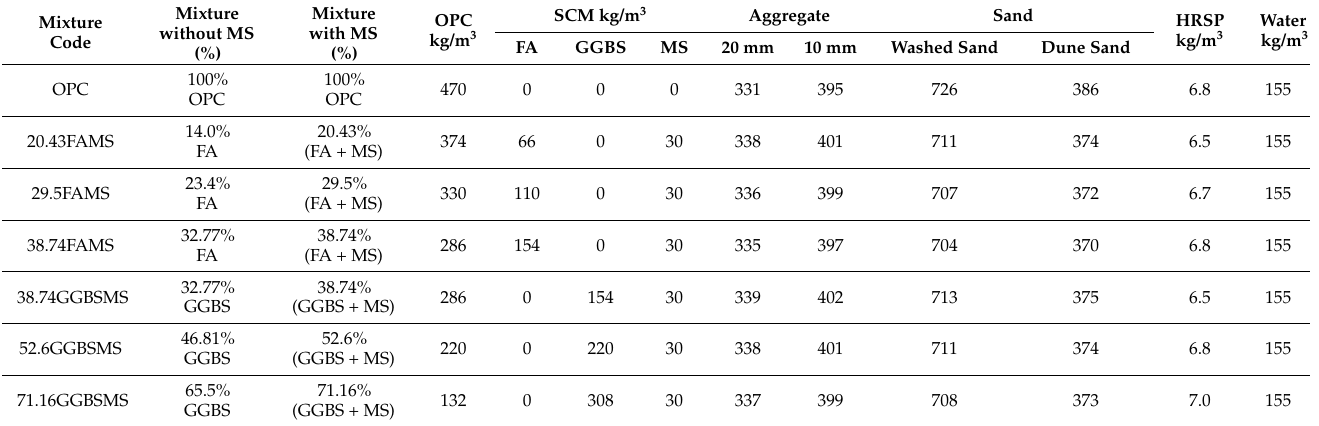
Table 5. SCC mixture proportions.